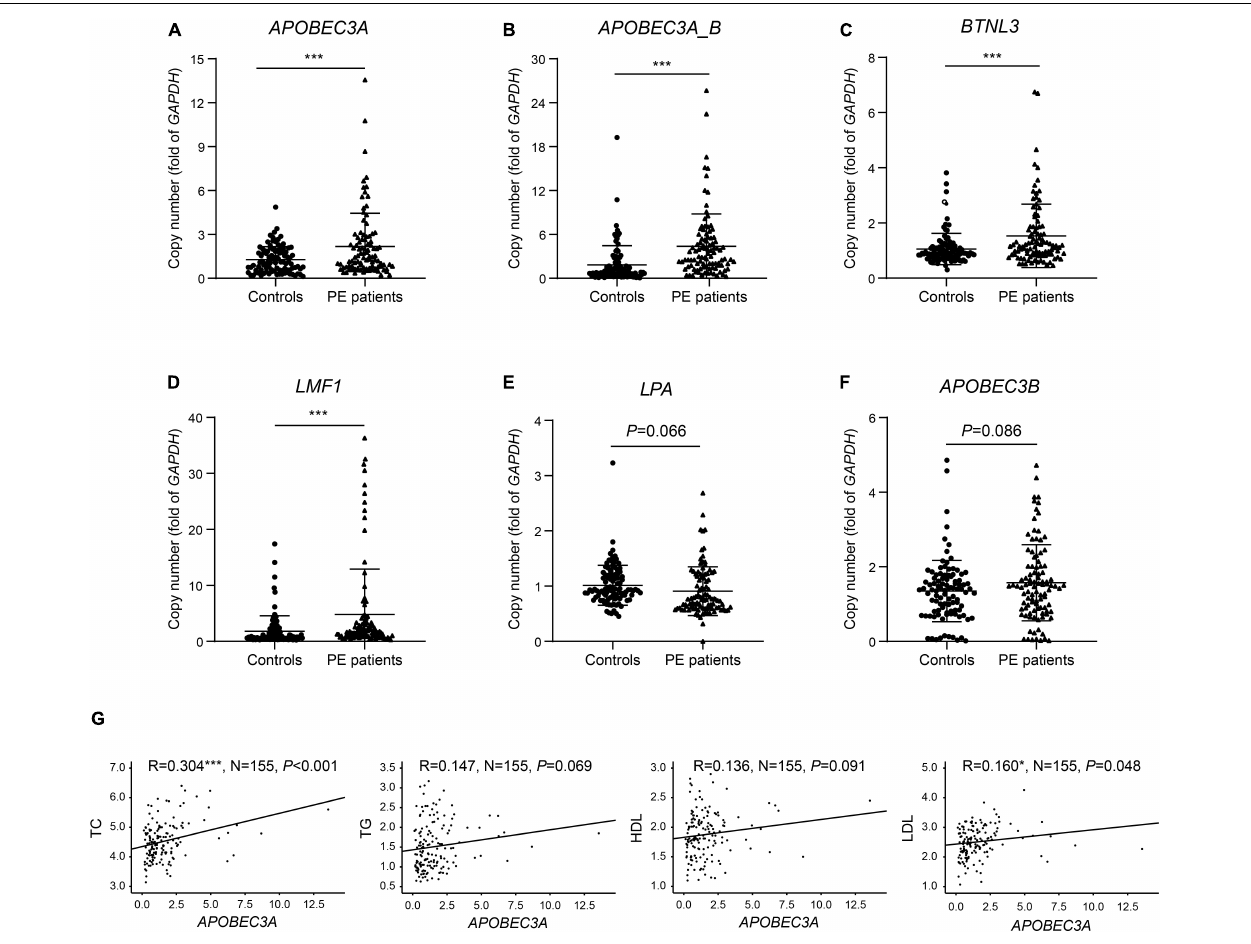
FIGURE 3 | Verification of copies for lipid metabolism-related genes and correlation of copies of APOBEC3A with lipid profiles. The copy numbers of (A) APOBEC3A , (B) APOBEC3A_B , (C) BTNL3 , (D) LMF1 , (E) LPA , (F) APOBEC3B in PE patients and controls ( n = 100/group). (G) Correlation of plasma lipid profiles with APOBEC3A copies ( n = 155). The unpaired two-tailed Student’s t -test determined statistical significances between two groups. The Pearson correlation coefficient analyzed the correlations. Data were represented as the mean ± SEM. *** P < 0.001, * P < 0.05. PE,